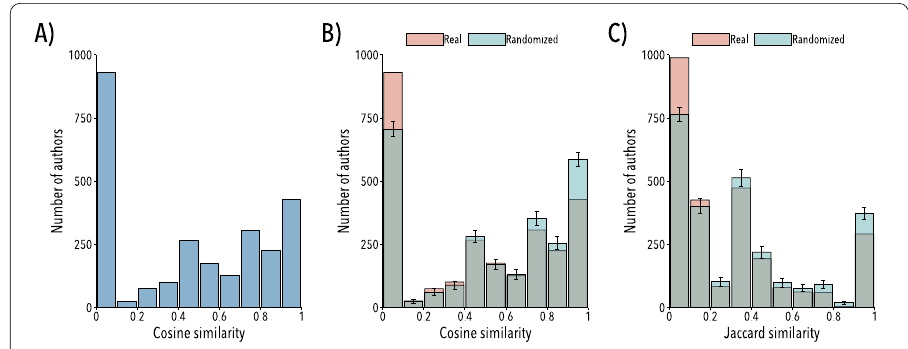
Figure 2 Cosine similarity distribution of authors’ interest who started their careers (published their first paper) in 1980. (panel ( A )) We compare authors’ interest vectors between the first and last year of publication. Interest vectors x i , S were built using the second level of the classification scheme with 68 PACS. (panel ( B )) Comparison between real data (pink bars) and a null model (green bars) where, for each author, an interest vector is constructed selecting, instead of the last year of publication, one year at random from the authors career. Average values and error bars are the results of 10 3 bootstraps. (panel ( C )) same comparison of panel ( B ) but the distance between vectors has been measured using the Jaccard index instead of the Cosine